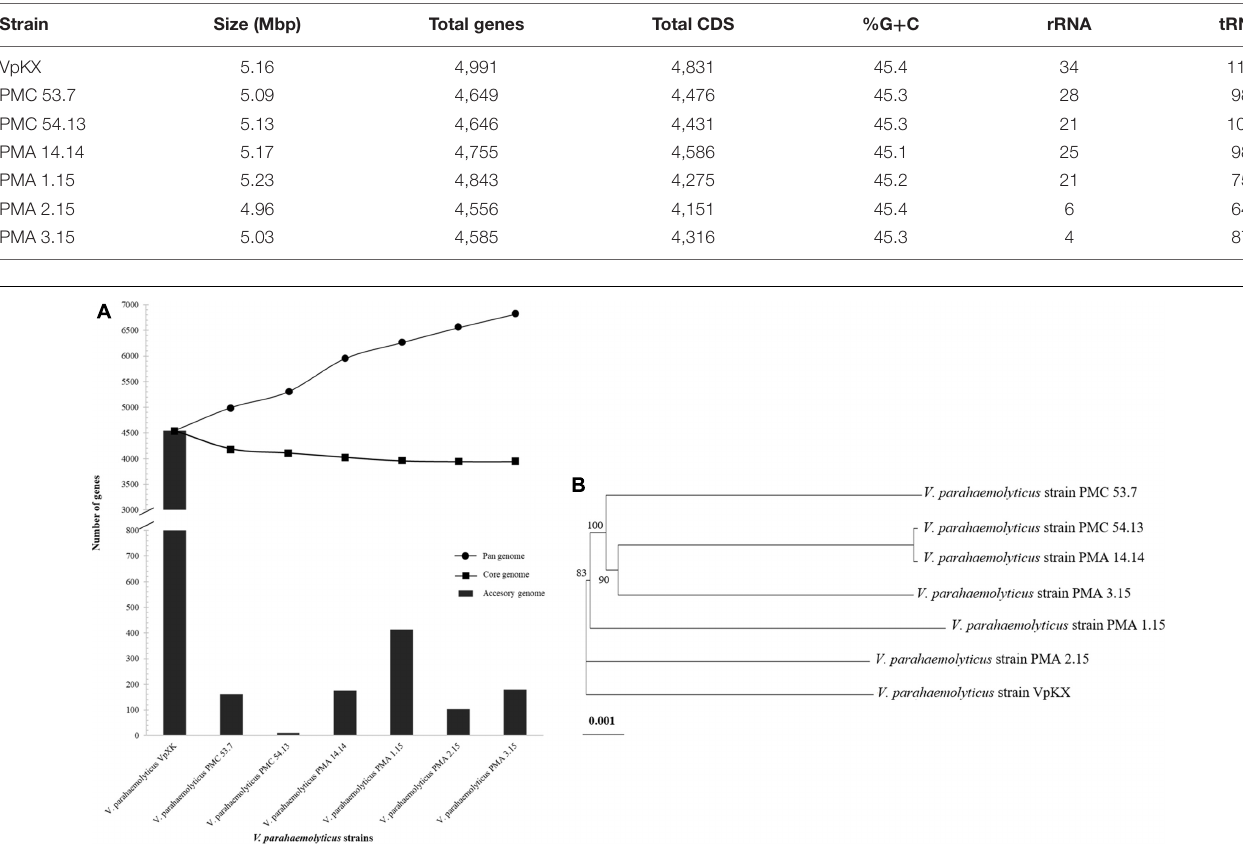
FIGURE 1 | Pan-genome and phylogenetic tree of V. parahaemolyticus strains. (A) Dynamics of pan-, core, and accessory genes found by progressive addition of V. parahaemolyticus genomes. (B) Maximum-likelihood tree obtained from a concatenated nucleotide sequence alignment of the orthologous core genes (3,943 genes) for the V. parahaemolyticus strains. The VpKX strain was included in the tree. Bootstrap values < 80% are not shown. The horizontal bar at the base of the figure represents 0.001 substitutions per nucleotide